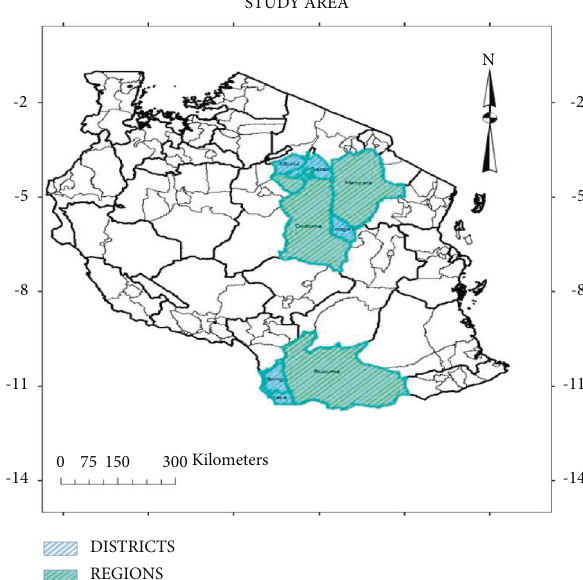
Figure 1: Study districts to assess challenges and opportunities in the diagnosis of T solium taeniosis/cysticercosis in